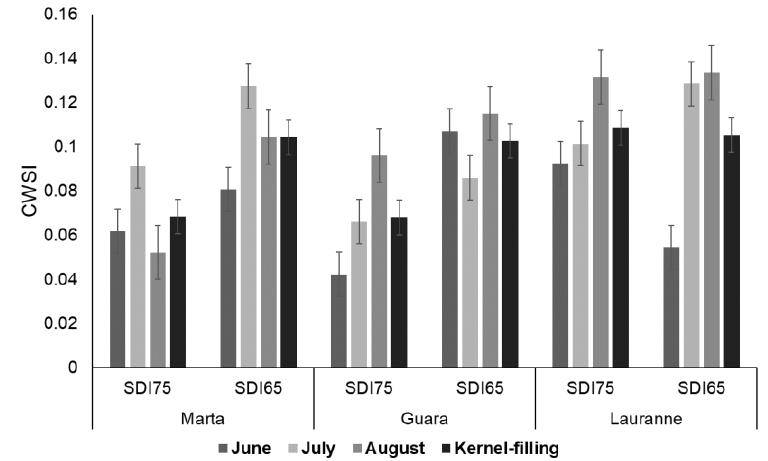
Figure 5. The crop water-stress index (CWSI) on a monthly basis for the water-stressed treatments (SDI) and studied cultivars. SDI 75 , irrigated at 75% of the irrigation requirements; SDI 65 , irrigated at 65% of the irrigation requirements. Vertical bars are standard deviation.